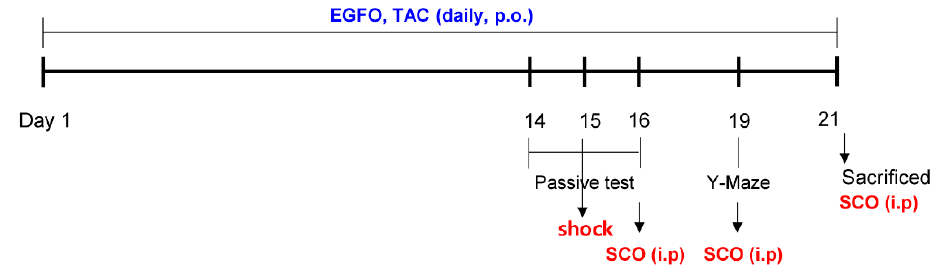
Figure 1. Description of the experimental design . ICR mice were orally administered vehicle, EGFO, or tacrine for 21 days. Scopolamine was administered 30 min prior to the step-through passive avoidance test (PAT) and Y-maze test. EGFO: Elaeagnus glabra f. oxyphylla ; TAC: Tacrine.